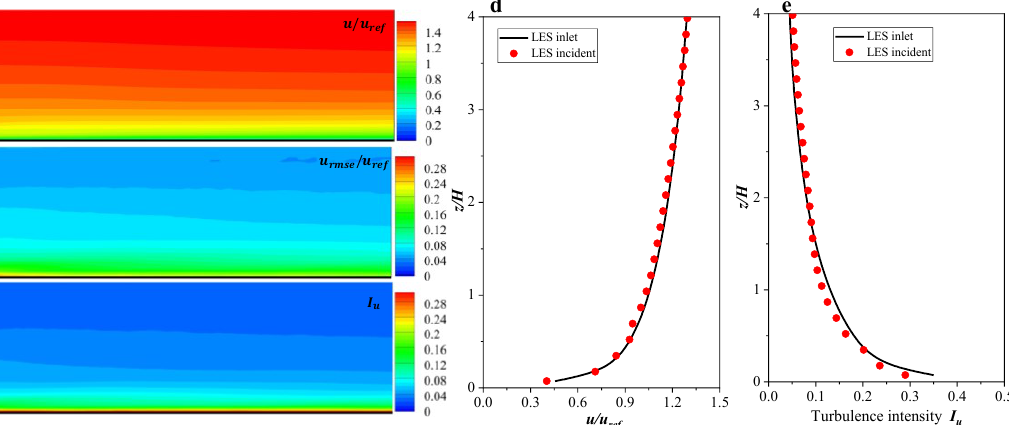
Figure 7. Self-preservation test of oncoming flow in LES calculation ( a – c ) Contour maps for 𝑢/𝑢 𝑟𝑒𝑓 , 𝑢 𝑟𝑚𝑠𝑒 /𝑢 𝑟𝑒𝑓 , 𝐼 𝑢 at xoz planer; ( d , e ) Quantitative comparison for 𝑢/𝑢 𝑟𝑒𝑓 and 𝐼 𝑢 at location of inlet and incident).